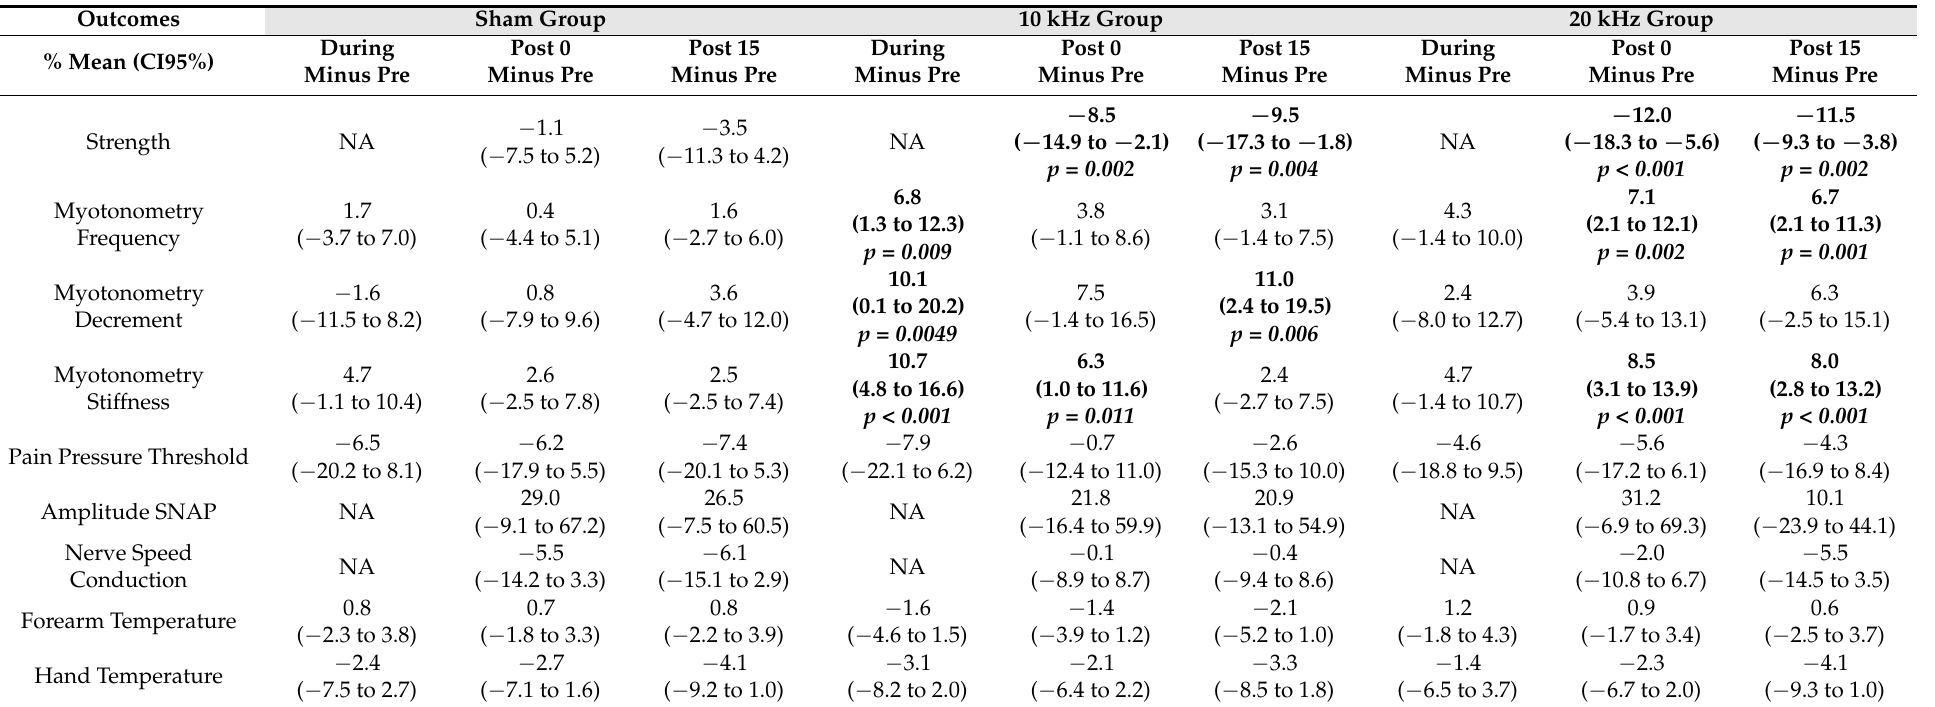
Table 2. Intragroup comparison from baseline. Bold values denote statistical significance. Abbreviations: PRE: preintervention; NA: not applicable; SNAP: sensory nerve action